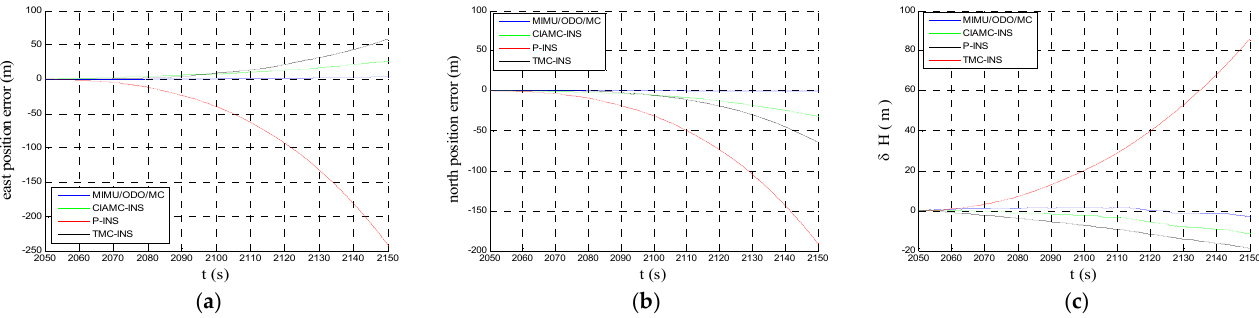
Figure 11. Position error curves of four algorithms without GNSS signal. ( a ) East position error curves; ( b ) north position error curves; ( c ) height position error curves.